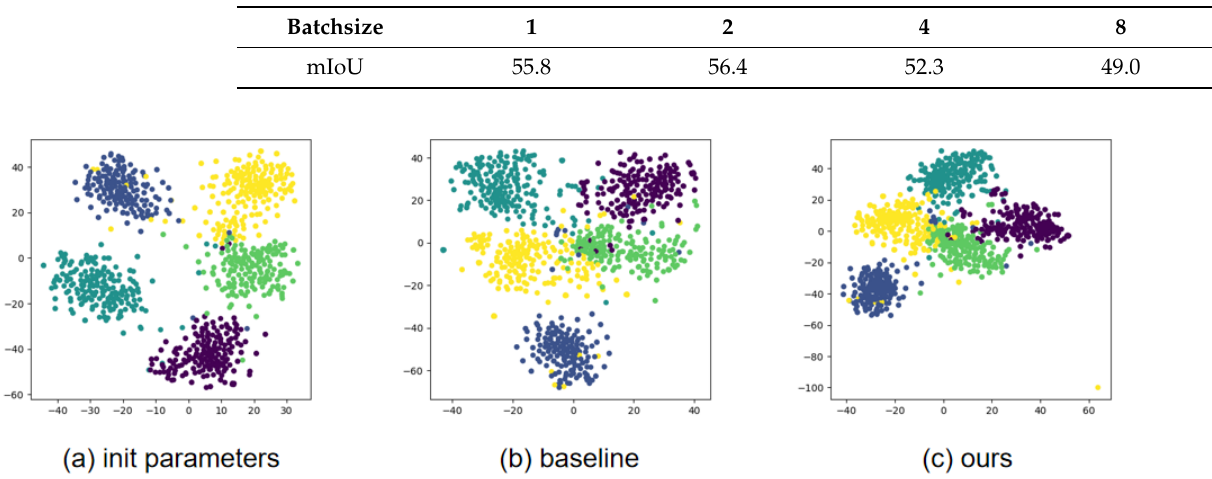
Table 7. Ablation studies on the batch-size of extra images in background learner.